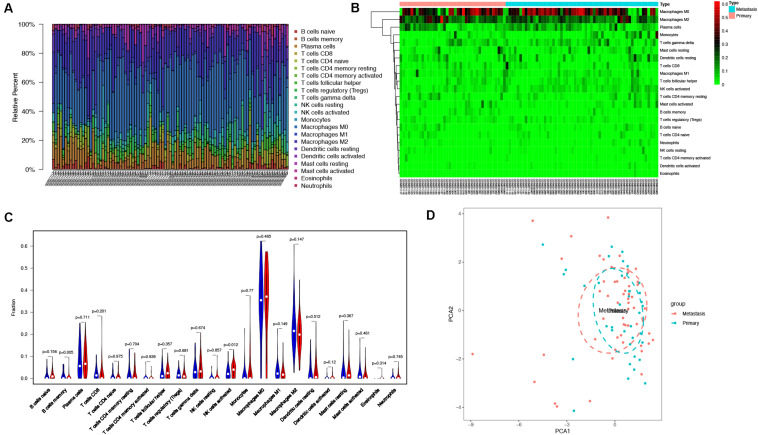
Immune cells infiltration analysis. (A) The distribution of 22 types of immune cells between primary and metastatic osteosarcoma tissues. (B) The difference of immune cells infiltration between primary and metastatic osteosarcoma tissues visualized by heatmap. (C) Violin plot visualizing the differentially infiltrated immune cells (P < 0.05). (D) PCA performed on all osteosarcoma tissues. The two principal components showed nothing significant variation. PCA, principal component analysis.